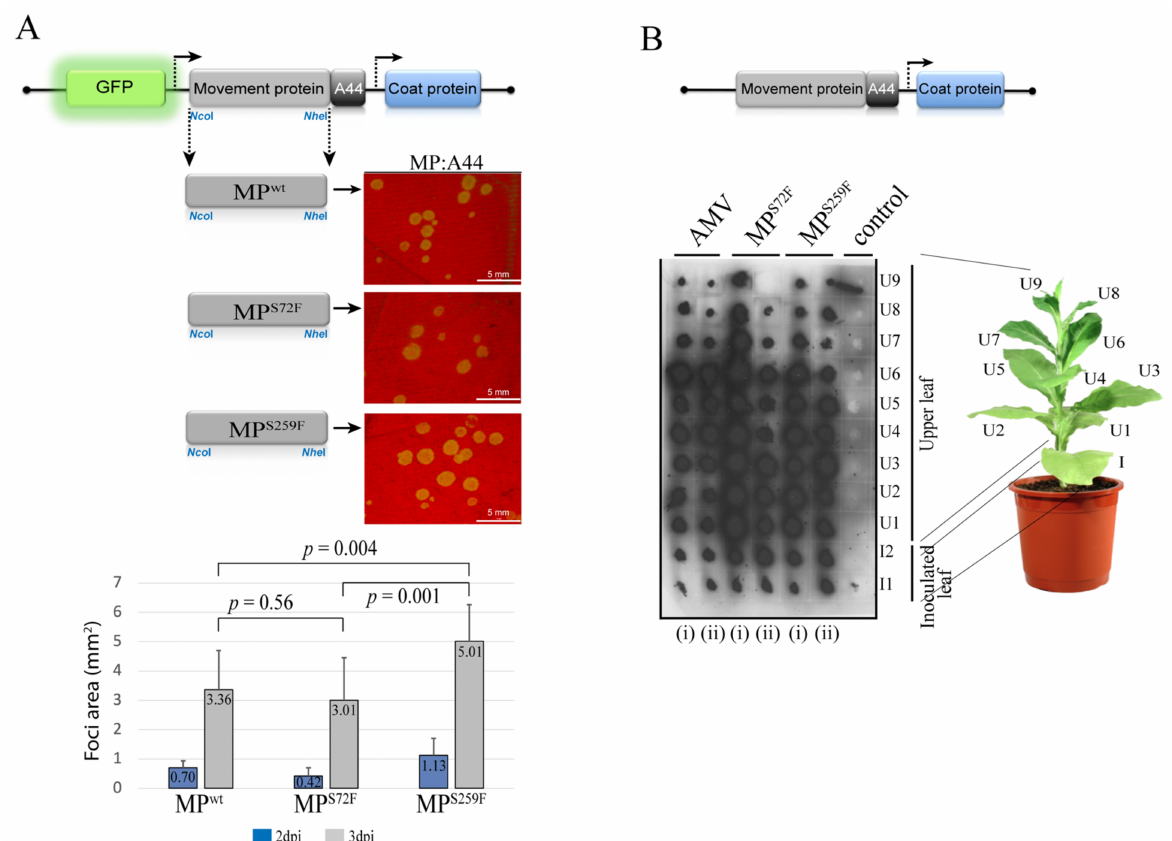
Figure 5. The presence of a phenylalanine at position 259 in the CiLV-C2 MP favors cell-to-cell transport. Analysis of the cell-to-cell and systemic transport of the hybrid AMV RNA 3 constructs carrying the CiLV-C2 MP wild type gene (MP WT ) or its MP S72F and MP S259F mutants. ( A ) Infection foci observed in P12 plants inoculated with RNA 3 transcripts from pGFP/A255/CP derivatives carrying the heterologous MPs fused to the C-terminal 44 residues of the AMV MP (A44). The schematic representation shows the GFP/A255/CP AMV RNA 3 construct [36], in which the open reading frames, represented by large boxes, correspond to the green fluorescent protein (GFP), the movement protein (MP), and the coat protein (CP). The short box corresponds to the A44, meanwhile, arrows represent subgenomic promoters. The Nco I and Nhe I restriction sites used to exchange the MPs are indicated. White bars correspond to 5 mm. Histograms represent the average of the area in mm 2 of 40 independent infection foci at 2 and 3 days post-inoculation (dpi). Error bars indicate the standard deviation. Student’s t -test and statistical significance were set at p ≤ 0.05. The p -values obtained from the comparison between pairs of groups are presented. ( B ) Tissue-printing analysis of P12 plants in duplicate (i and ii) and inoculated with the AMV RNA 3 derivatives showed in ( A ) but lacking the 5 (cid:48) -proximal GFP gene. Plants were analyzed at 14 dpi by printing the transversal section of the corresponding petiole from inoculated (I) and upper (U) leaves. Control corresponds to a healthy plant. This assay was repeated three